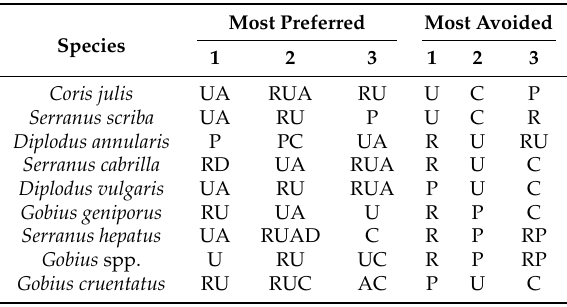
Table 5. The top three preferred and avoided habitats for each aggressive predator